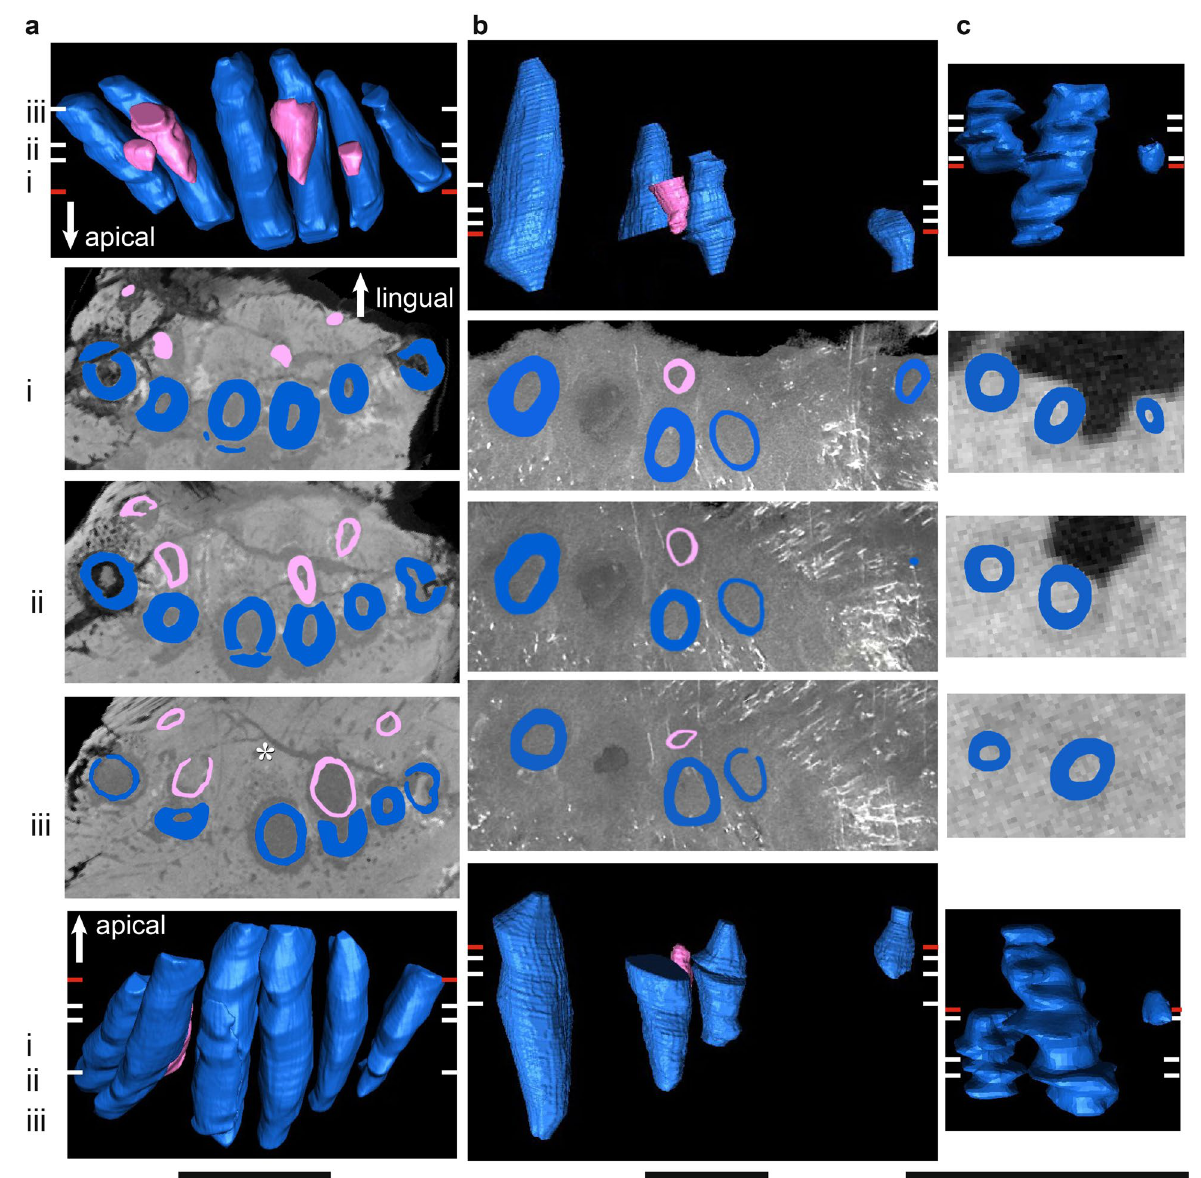
Figure 8. µCT scans of basal dicynodont maxillary ‘postcanine’ teeth in horizontal section (middle three rows), lingual view (top row), and labial view (bottom row). ( a ) Pristerodon mackayi NHCC LB231 (mirrored), ( b ) Brachyprosopus broomi FMNH UR 2513, ( c ) Compsodon helmoedi NHCC LB211 (mirrored). Horizontal sections were taken at numbered positions indicated on the labial and lingual views. The level of the gumline is indicated by a red tick mark on labial and lingual views. Replacement teeth are highlighted in light pink and functional teeth in medium blue. Anterior is to the left. Scale bars 5 mm. Asterisks indicate visible alveolar bone